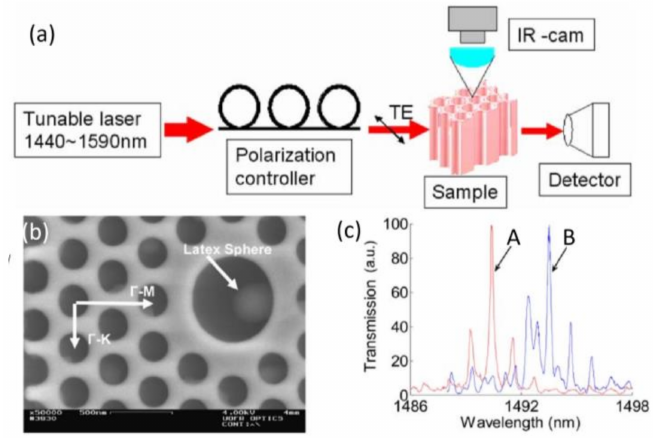
Figure 2. Schematic of the experimental setup: ( a ) A tunable laser (1440 to 1590 nm) is used as the source, and TE-polarized light is generated using a polarization controller plate. Light is coupled in and out of the PC through ridge waveguides. An InGaAs detector is used to measure the transmitted signal; ( b ) top view of the device with one latex sphere captured in the central defect; ( c ) normalized transmission spectra; Curve A is measured before capture, and curve B is measured after one latex sphere is infiltrated inside the defect. Adapted with permission from reference [70]. Copyright (2007) Optical Society of America